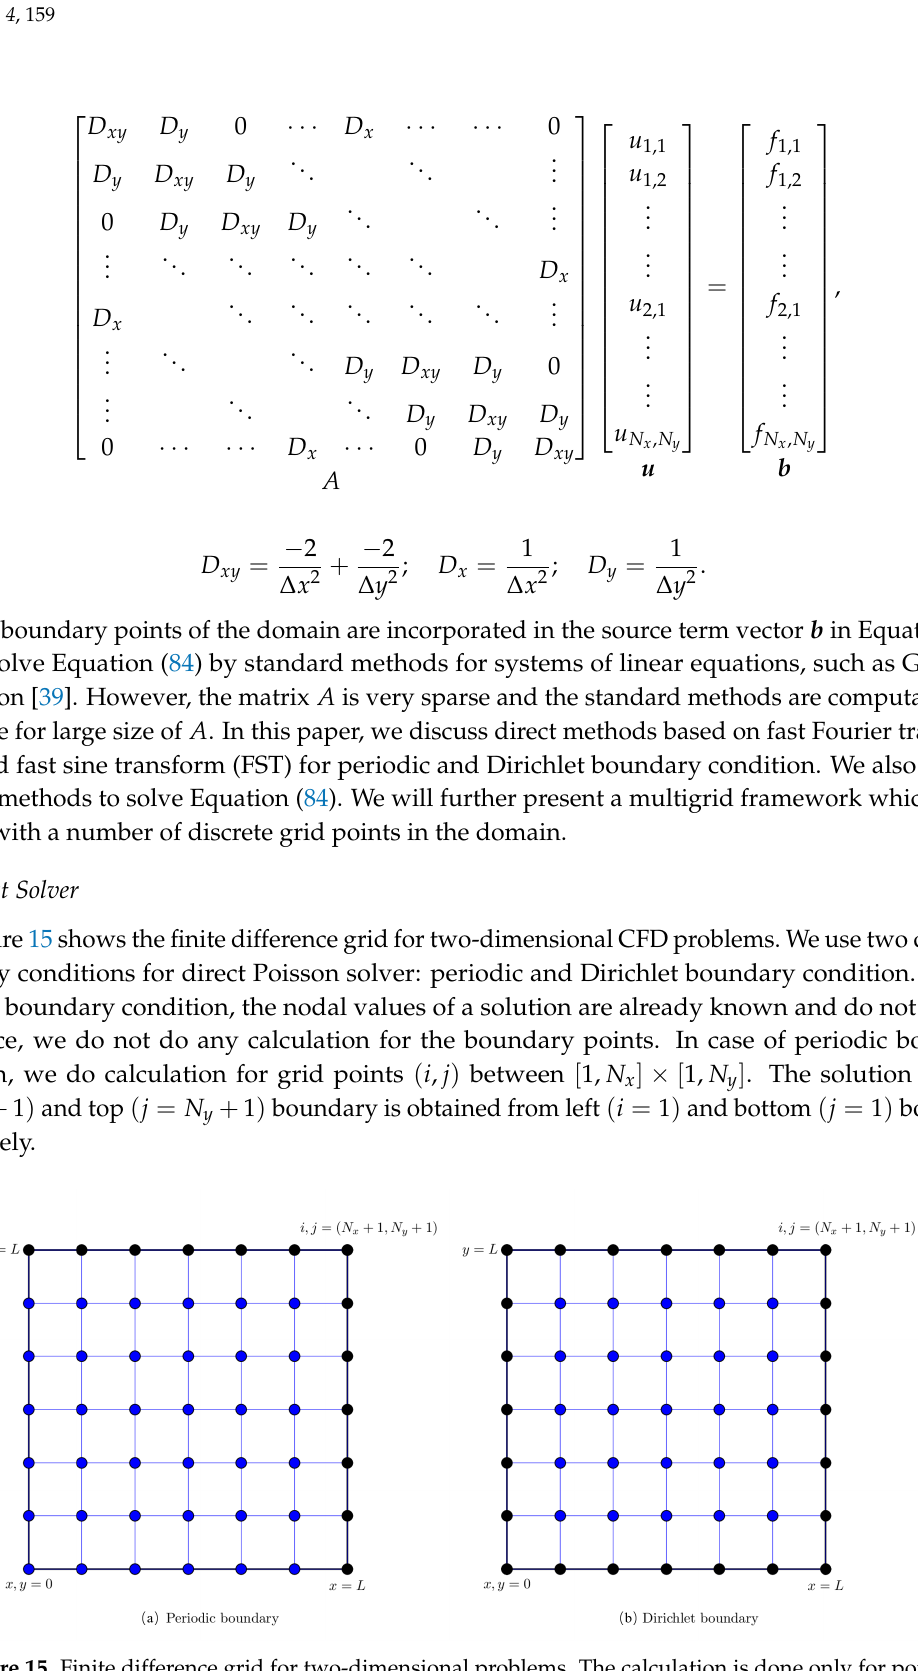
Figure 15. Finite difference grid for two-dimensional problems. The calculation is done only for points shown by blue color. The solution at black points is extended from left and bottom boundary for periodic boundary condition. The solution is already available at all four boundaries for Dirichlet boundary